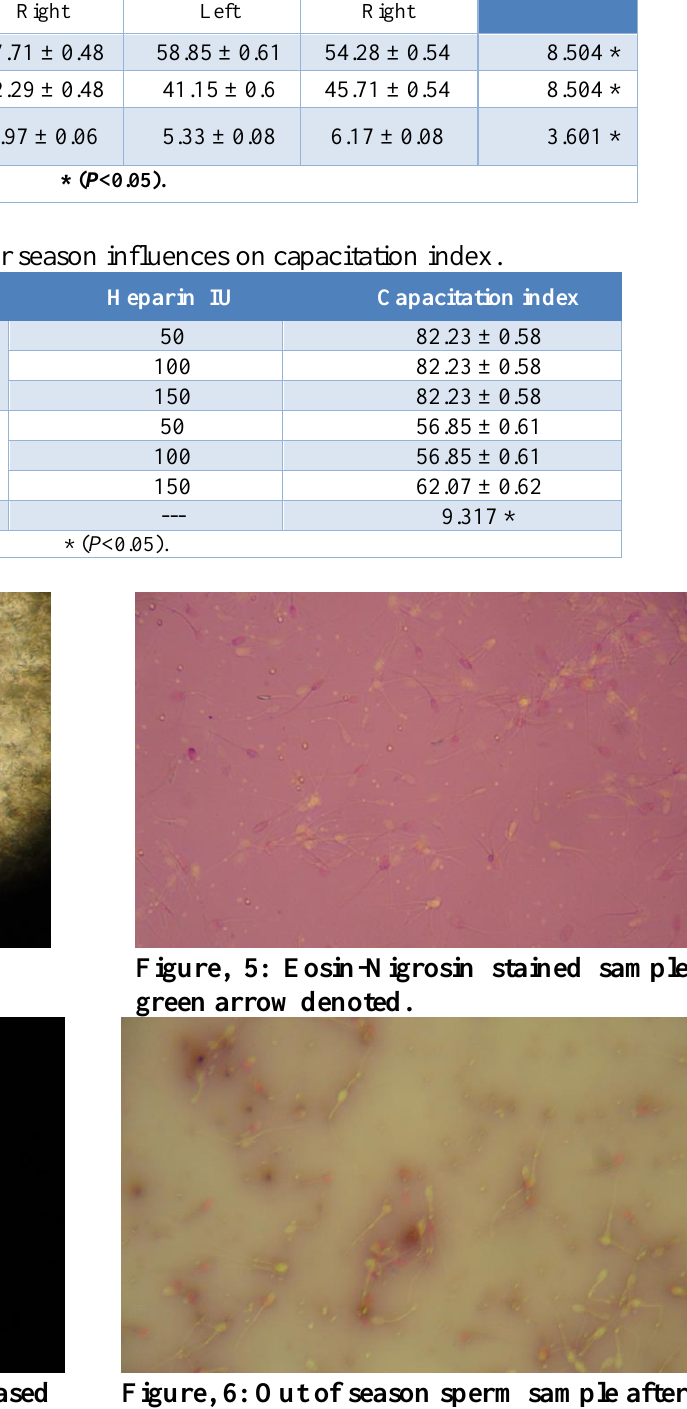
Figure, 4: Progress viability and increased fertilizable activity of sperm after capacitation.